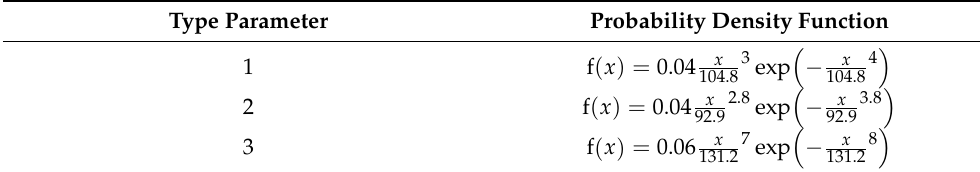
Figure 3. Passenger generation algorithm. Table 1. Probability density function of reporting time before departure depending on the TYPE parameter.